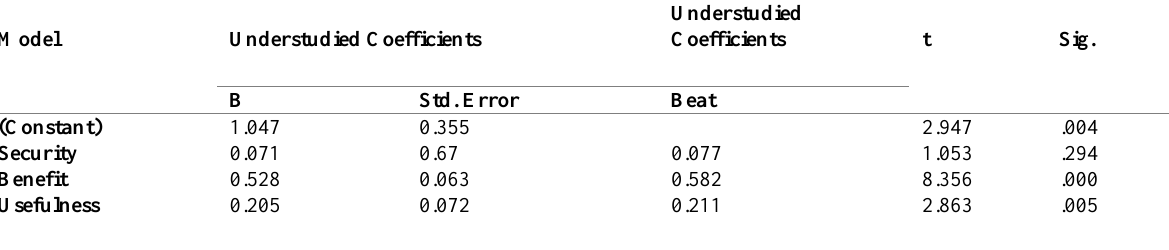
Table 9: Determinant Coefficient of